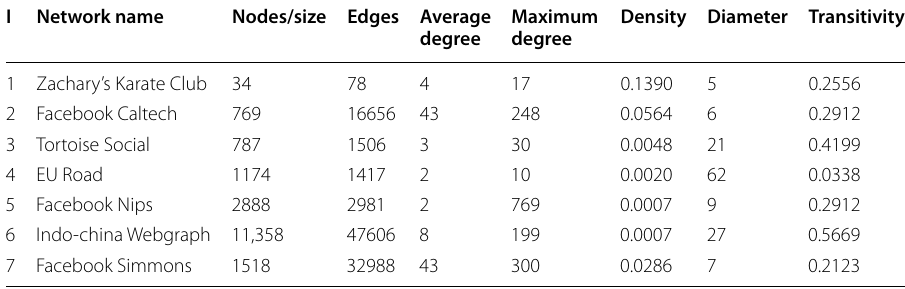
These networks were taken from a network repository (Csardi and Nepusz 2006; Traud et al. 2011, 2012; http:// netwo rkrep osito ry.